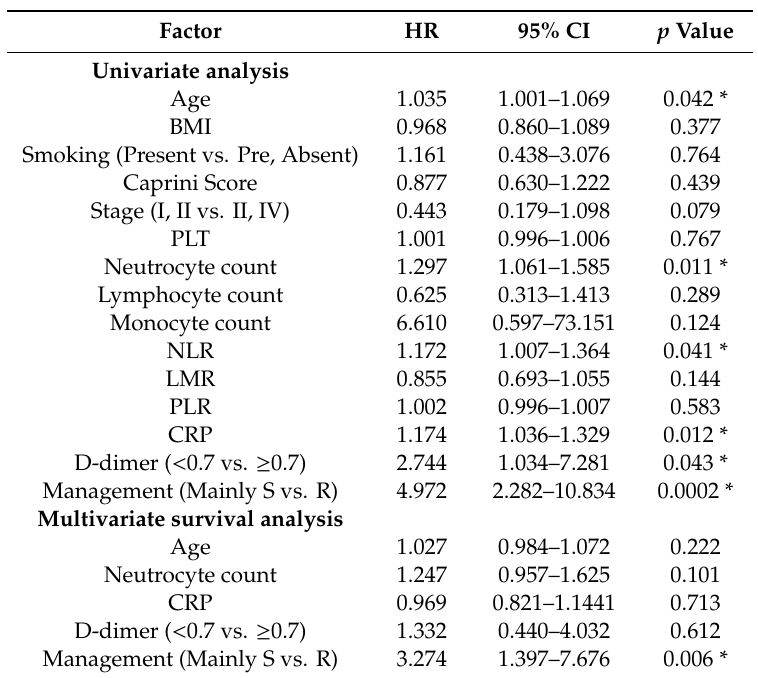
Figure 1. Kaplan–Meier analysis according to D-dimer with a median of 0.7. When patients were stratified by D-dimer, the overall survival rate was 77.8% for patients with low D-dimer ( < 0.7) and 57.3% for patients with high D-dimer ( ≥ 0.7). This di ff erence was significant ( p = 0.035). Table 4. Prognostic factors for overall survival a